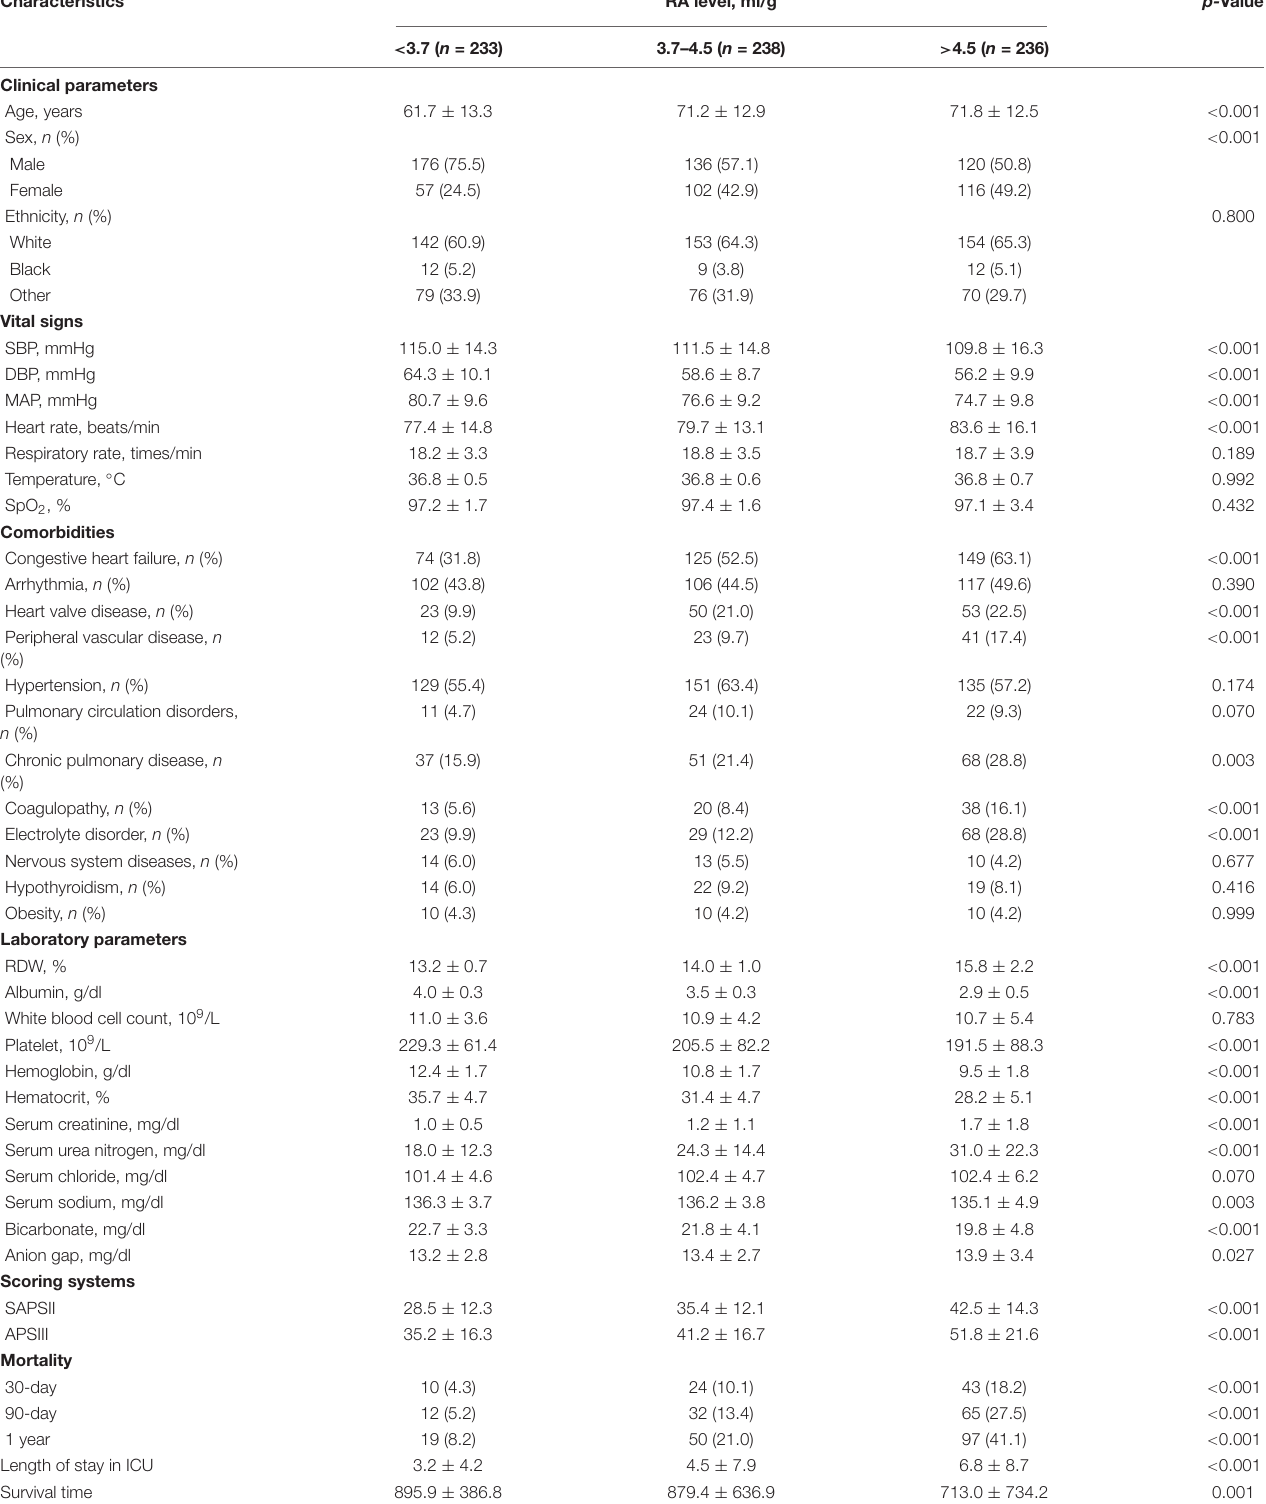
TABLE 1 | Baseline characteristics of the study population.